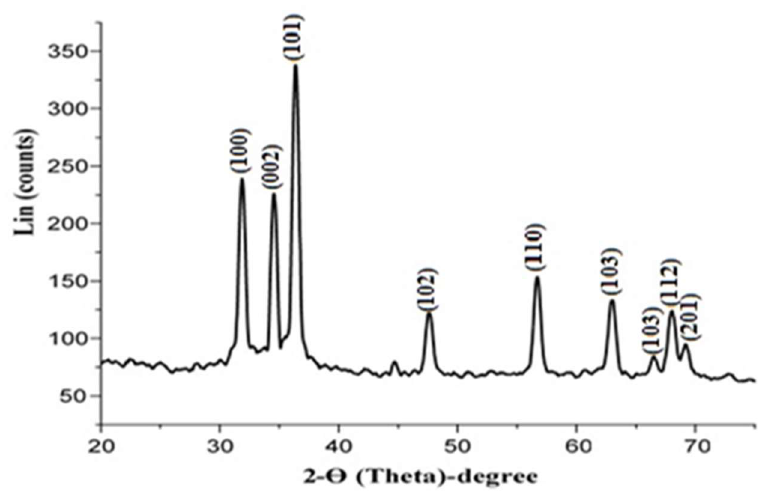
Figure 9. XRD analysis of ZnO-NPs.